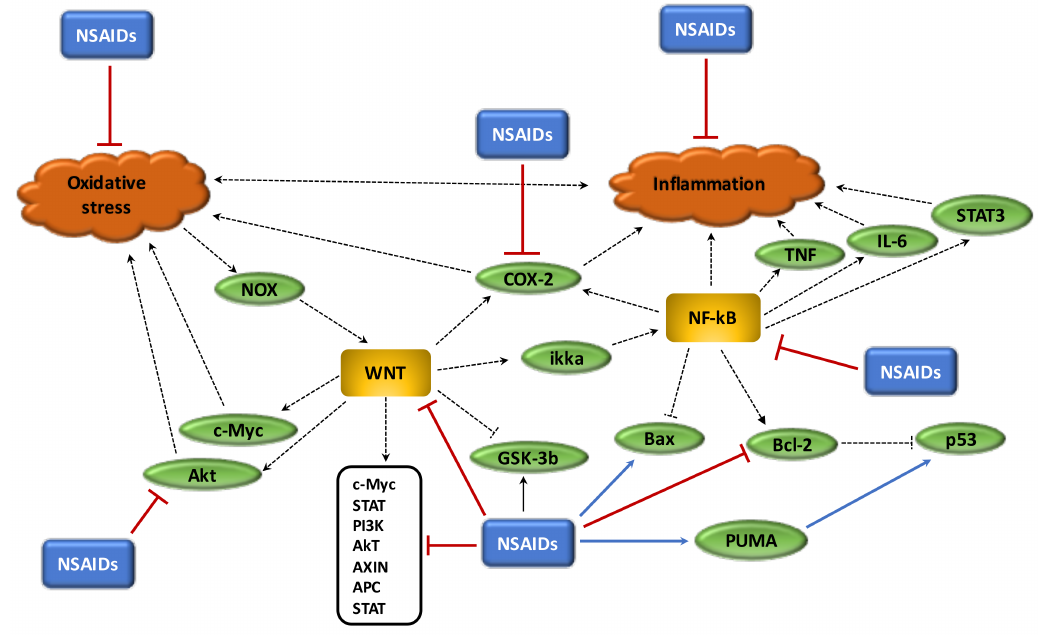
Figure 5. Beneficial role of NSAIDs in cancer process. (1) NSAIDs reduce oxidative stress; (2) NSAIDs reduce chronic inflammation; (3) NSAIDs inhibit Akt pathway activity; (4) NSAIDs downregulate WNT pathway and its target genes, inhibit Bcl-2, activate PUMA to stimulate p53 and activate GSK-3beta; (5) NSAIDs inhibit NF- κ B and